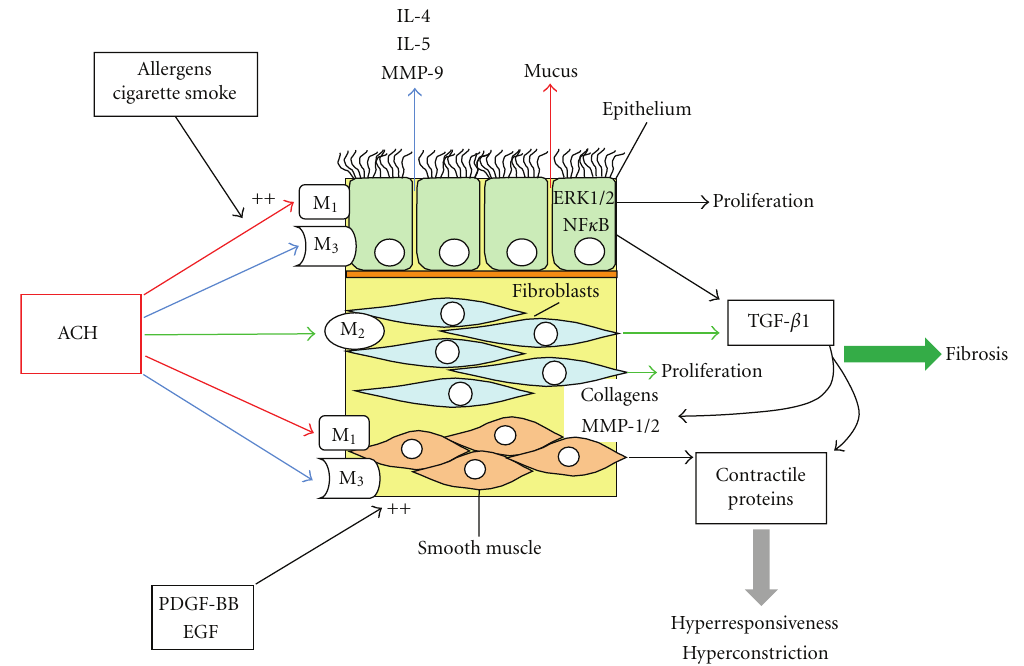
Figure 3: Cell type and muscarinic receptor specific e ff ects on airway wall